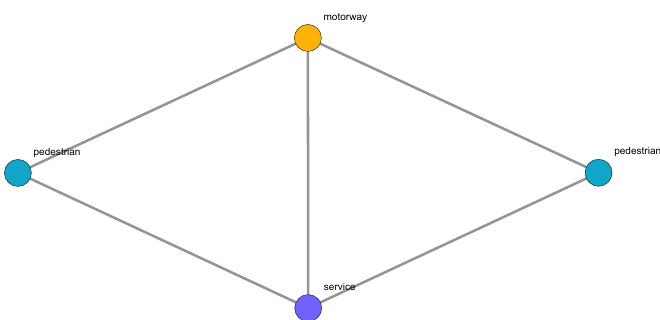
after contraction of the same-color adjacent nodes. G ( V , E ) (cid:0) (cid:1)